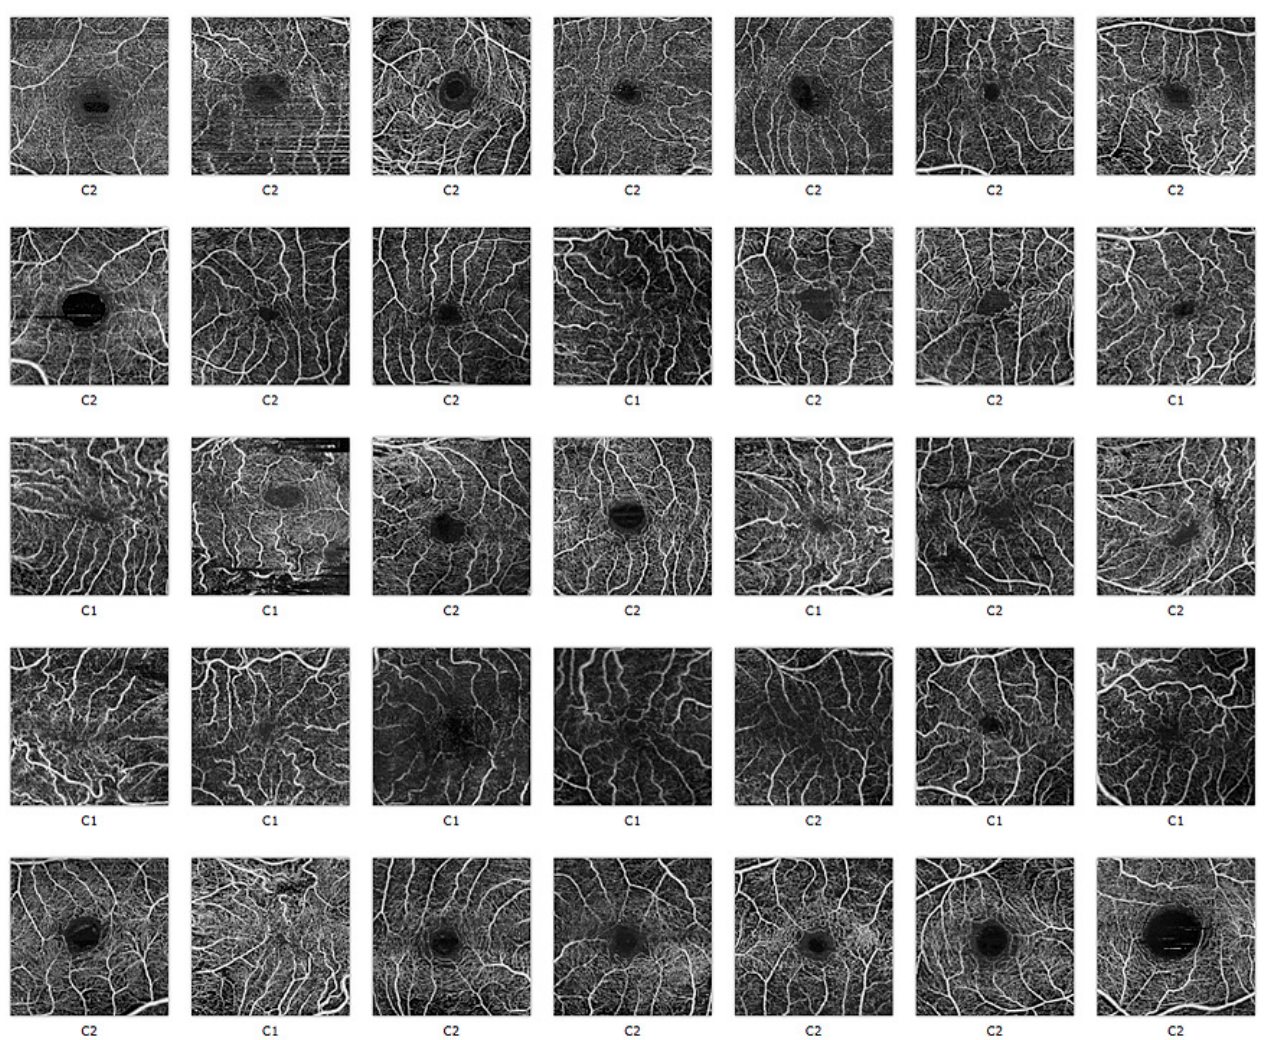
Figure 6. Superficial vascular plexus of OCT-A images, as assigned to Cluster 1 or 2 by the clustering algorithm based on the Inception V3 feature extraction.